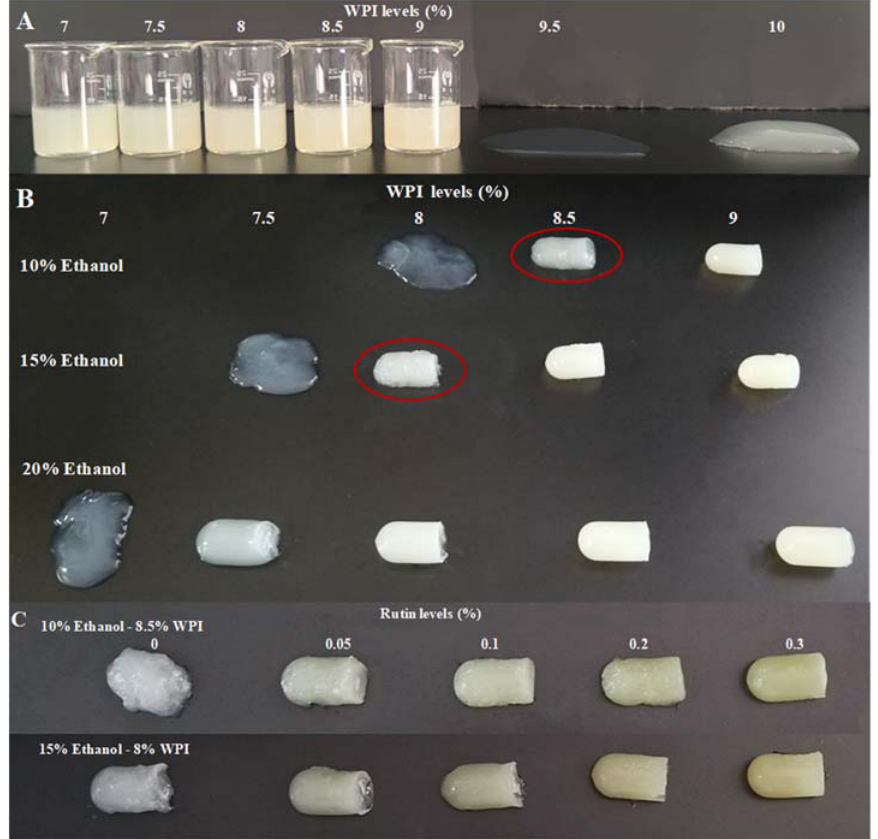
Figure 1. The photographs of WPI-based gels at different WPI levels (7%, 7.5%, 8%, 8.5%, 9%, 9.5% and 10% w / v ) ( A ), ethanol levels (10%, 15% and 20% w / v ) ( B ) and rutin levels (0.05%, 0.1%, 0.2% and 0.3% w / v ) ( C ).